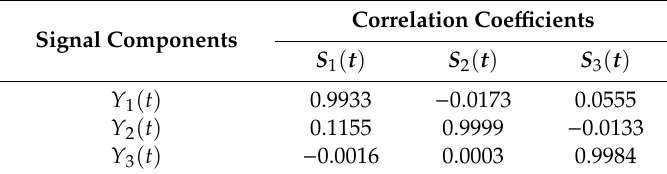
Figure 5. Separated signals using the improved SOBI method. ( a ) Separated signal Y 1 ( t ) , ( b ) separated signal Y 2 ( t ) , and ( c ) separated signal Y 3 ( t ) . Table 1. Correlation coefficient between the separated signal and the source signal.